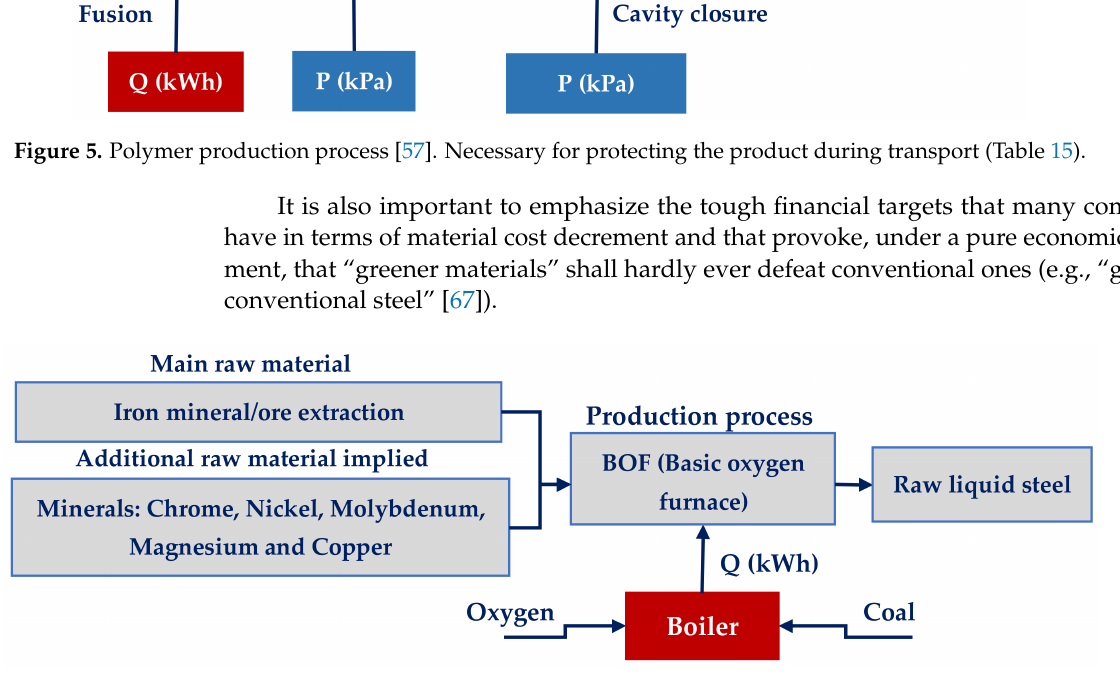
Figure 6. Steel production process [68]. Necessary to produce the main product structure/body (Tables 4 and